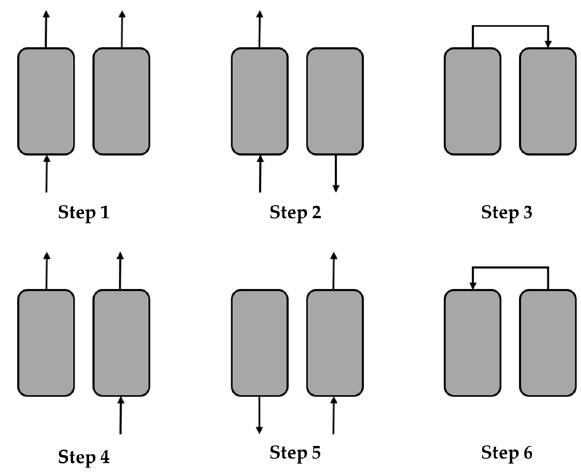
Figure 3. Schematic diagram of the dual-bed six-step PSA process. Table 4. Step time of the dual-bed six-step PSA process.